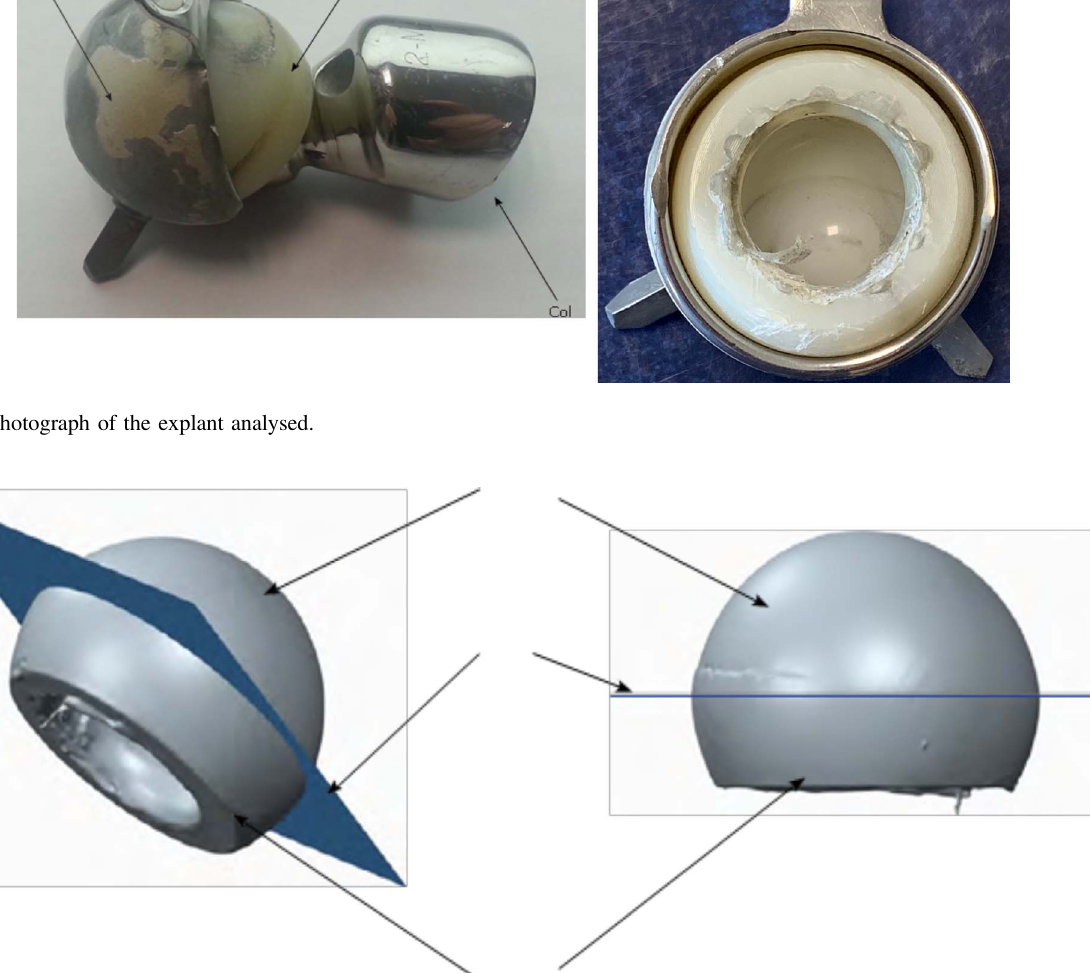
Figure 3. Plans of study.